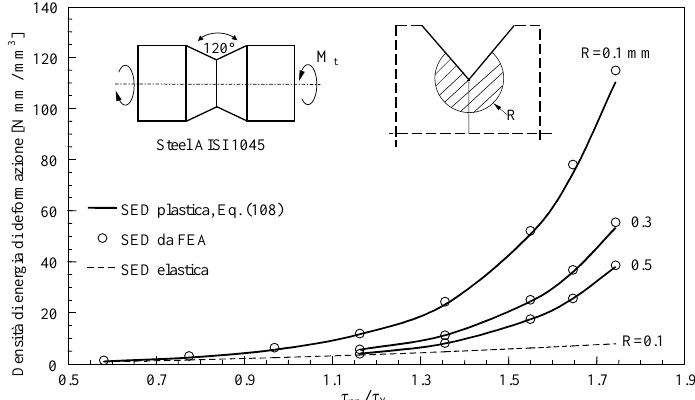
Figura 17: Densità di energia di deformazione in accordo con l’ Eq. 108 e confronto con i risultati di alcune analisi agli elementi finiti;